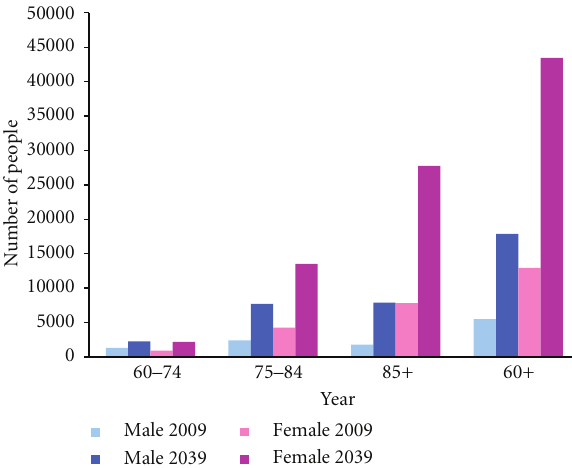
Figure 2: Estimated and projected numbers of people living in institutions with dementia in Hong Kong, by age group and sex, 2009 and 2039. Data sources: authors’ calculations based on data from Census and Statistics Department of Hong Kong [3, 11].